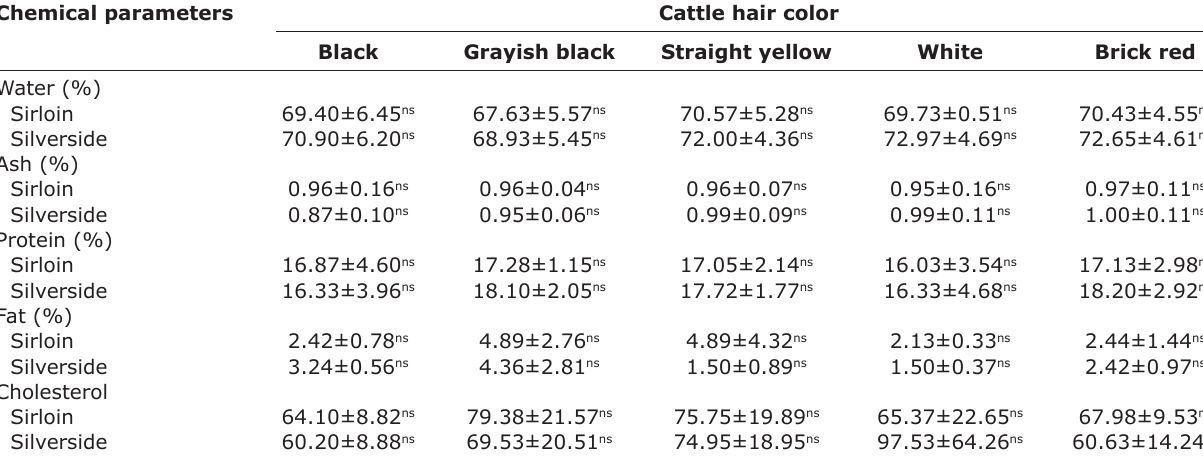
Table -3: Meat chemical parameters (±SD) of Aceh cattle with different hair colors. Chemical parameters